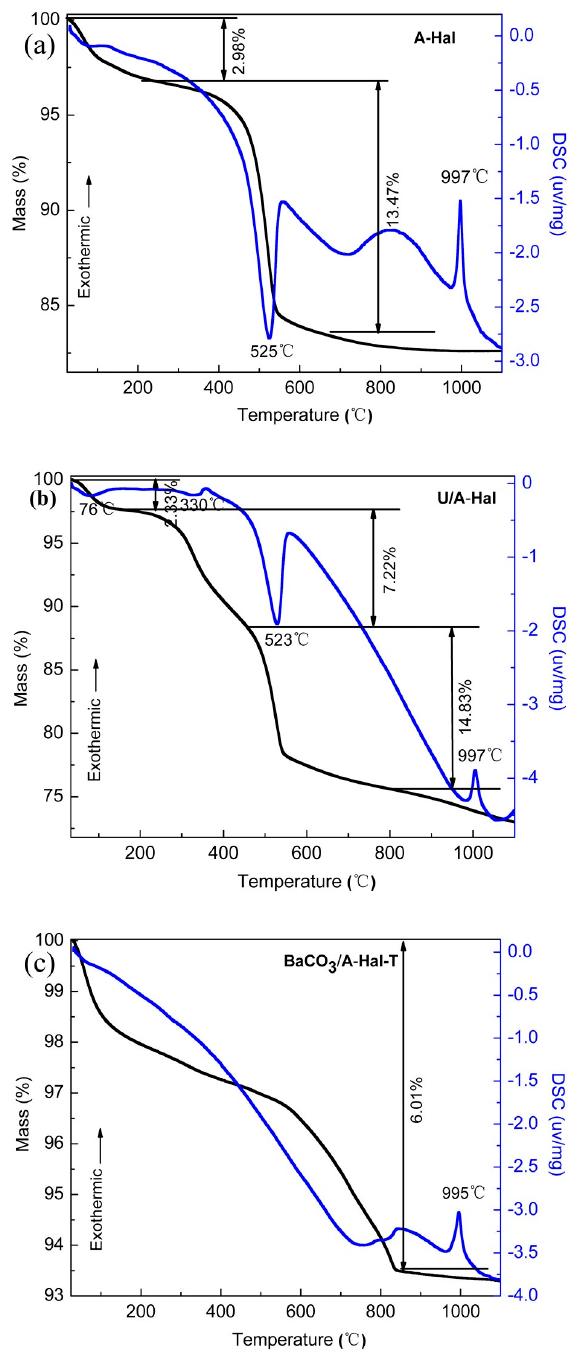
Figure 4. TG-DSC curves of ( a ) A-Hal, ( b ) U/A-Hal and ( c ) BaCO 3 /A-Hal-T samples.